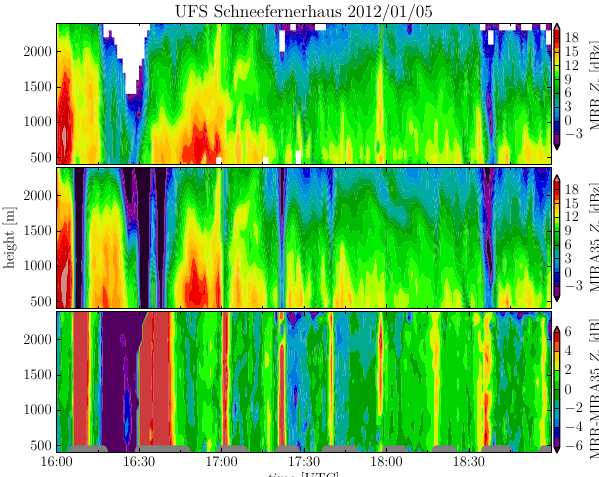
Fig. 2. Time-height effective reflectivity plot of MRR Z e (top), MIRA35 Z e (centre) and their dual wavelength difference 1Z e (bottom). The presented data is already corrected for constant cali- bration offsets. The operation time of MIRA35’s heating is marked in grey in the bottom